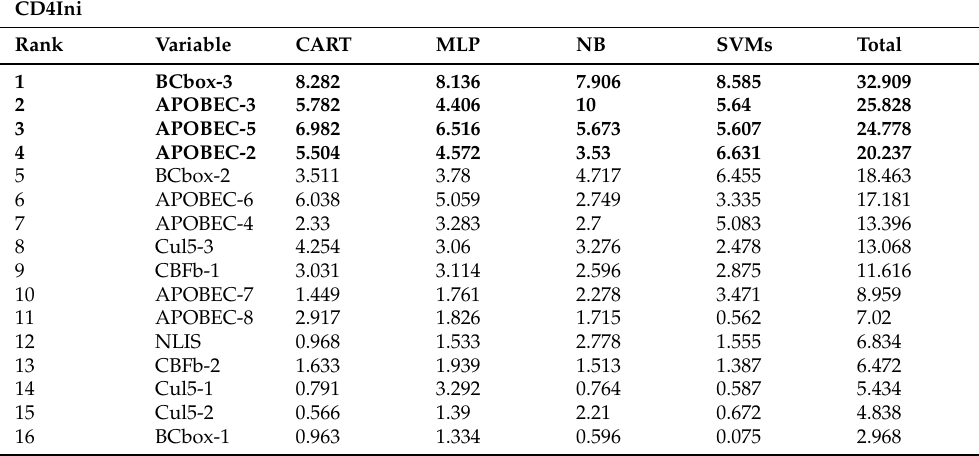
Table A5. Assessment on the variables considering the clinical endpoints using the MAREV-1 approach. The variables with values surpassing the calculated threshold are highlighted in